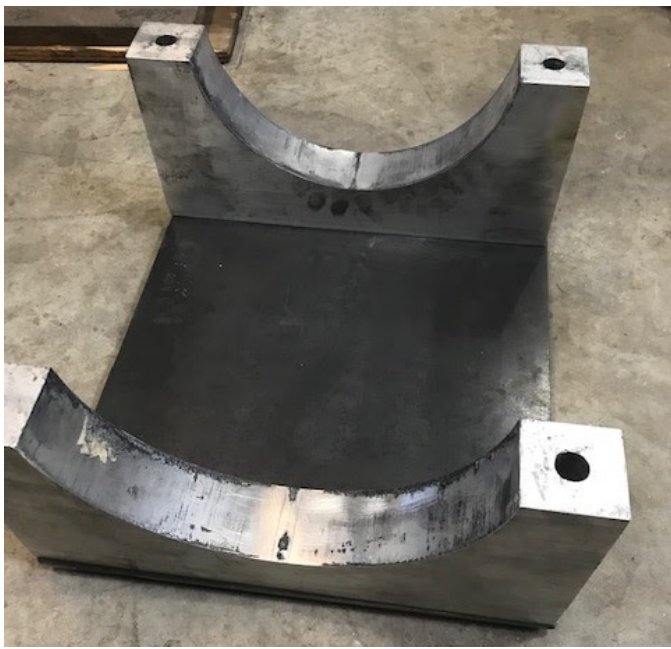
Figure 5. Half of the moment clamp used to reinforce the hand-hole after initial failure. Nine poles, each with two hand-holes, were tested at stress ranges between 17.24 MPa (2.5 ksi) and 58.61 MPa (8.5 ksi). Figure 6 depicts a sketch of where the strain gages were